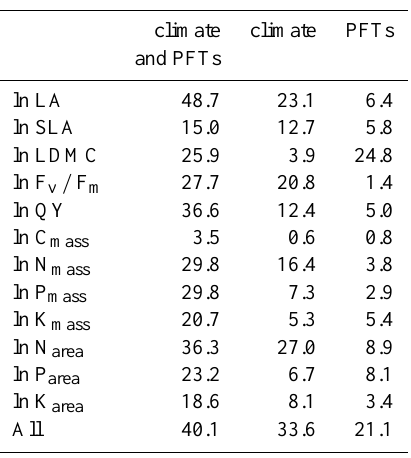
Table 3. Variation (%) in traits accounted for by climate ( α and GDD 0 ) and PFTs together, and the unique contributions (%) of cli- mate and PFTs, based on the first two axes of a redundancy analysis for the sites with data for all traits. climate climate